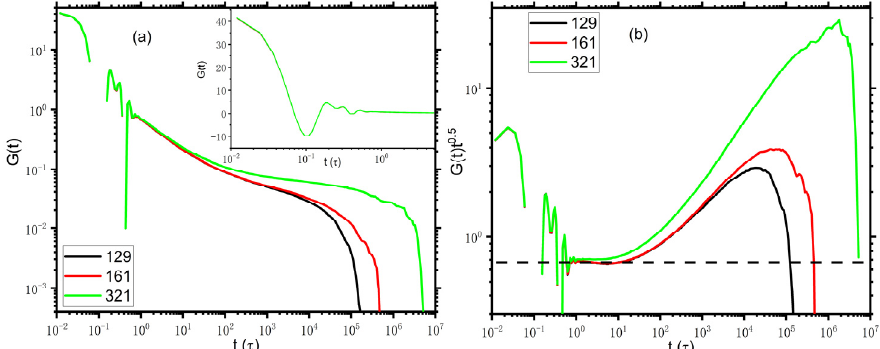
Figure 1. ( a ) Stress relaxation for DPD polymer chains with N = 129, 161, and 321. The inset shows the bond length relaxation regime at an early time for N = 321. ( b ) The same with panel ( a ), but the vertical coordinate is normalized by the power law of the Rouse dynamics regime t 0.5 . The horizontal dash line indicates the pure Rouse behavior.